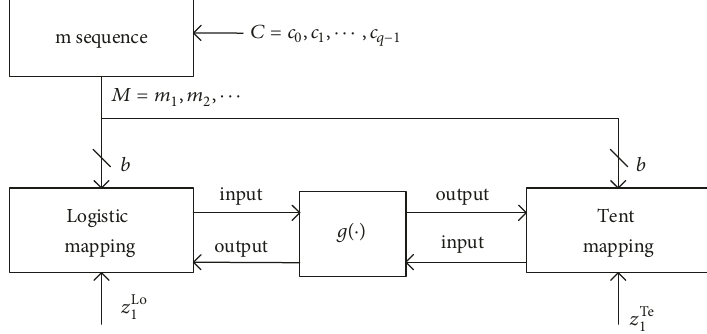
Figure 4: Block diagram of the novel discrete chaotic sequence generator.